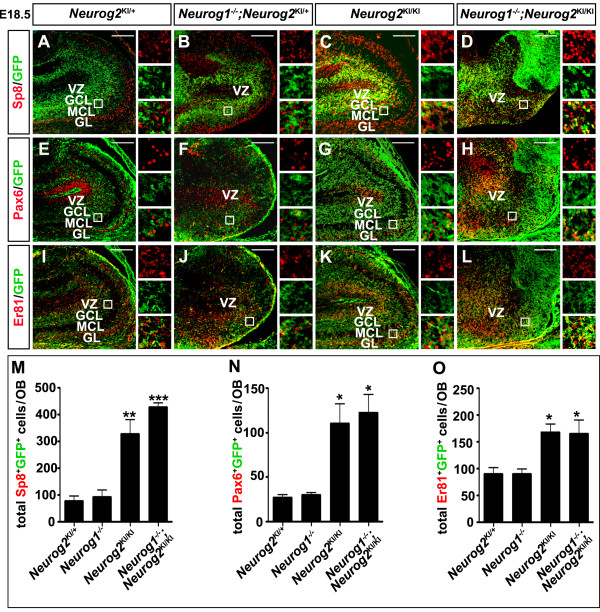
Neuronal misspecification defects in Neurog2−/− olfactory bulbs and Neurog1/2 −/− olfactory bulb-like structures. (A) to (L) Co-immunostaining of GFP (green, A to L) with Sp8 (red, A to D), Pax6 (red, E to H) or Er81 (red, I to L) in E18.5 wild-type, (A,E,I), Neurog1−/− (B,F,J), Neurog2KI/KI (C,G,K), and Neurog1/2−/− (D,H,L) OBs. Insets to the right of each panel are fourfold magnifications of boxed areas. (M) to (O) Quantitation of total Sp8+GFP+ cells (M), Pax6+GFP+ cells (N), and Er81+GFP+ cells (O) in embryonic day 18.5 wild-type, Neurog1−/−, Neurog2KI/KI and Neurog1/2−/− OBs. *P <0.05, **P <0.01, ***P <0.005. GCL, granule cell layer; GL, glomerular layer; MCL, mitral cell layer; VZ, ventricular zone. Scale bars: 500 μm (A) to (L).